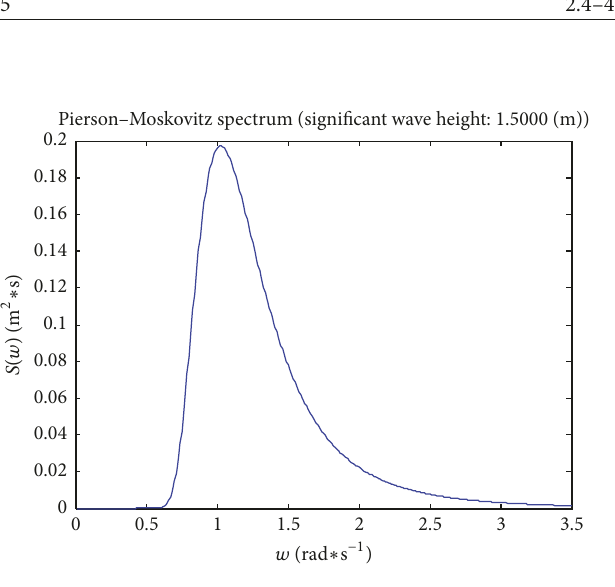
Here, 𝐻 0 is defined